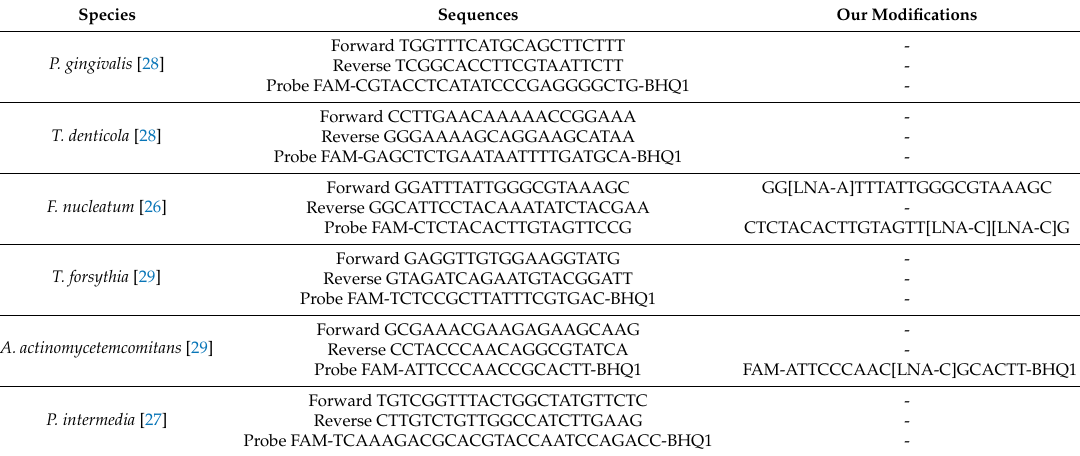
Table 1. Oligonucleotide sequences used in related research and our modifications Species Sequences Our